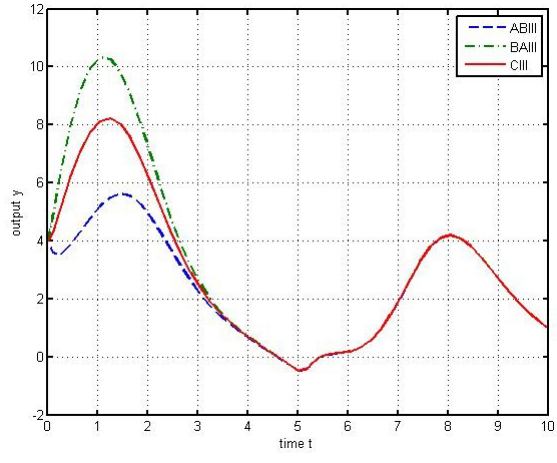
Fig. 4. Outputs of Example 2 for Case